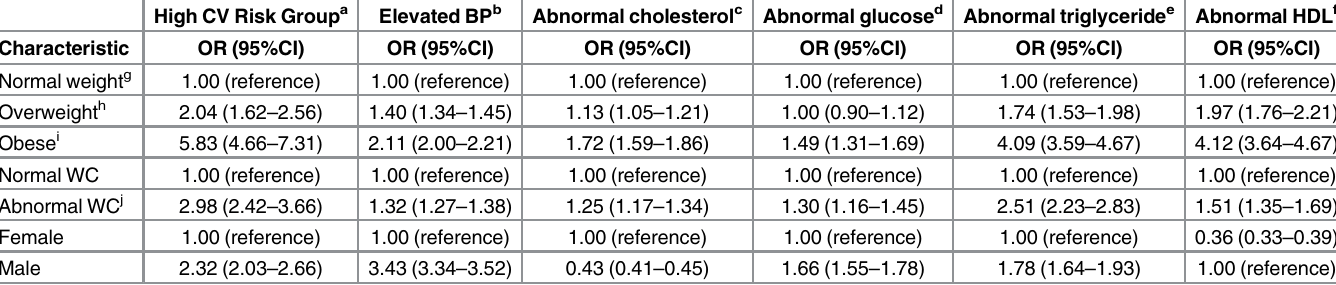
Table 3. The odds ratio (OR) of the different BMI and WC categories having the cardiovascular risk factors. High CV Risk Group